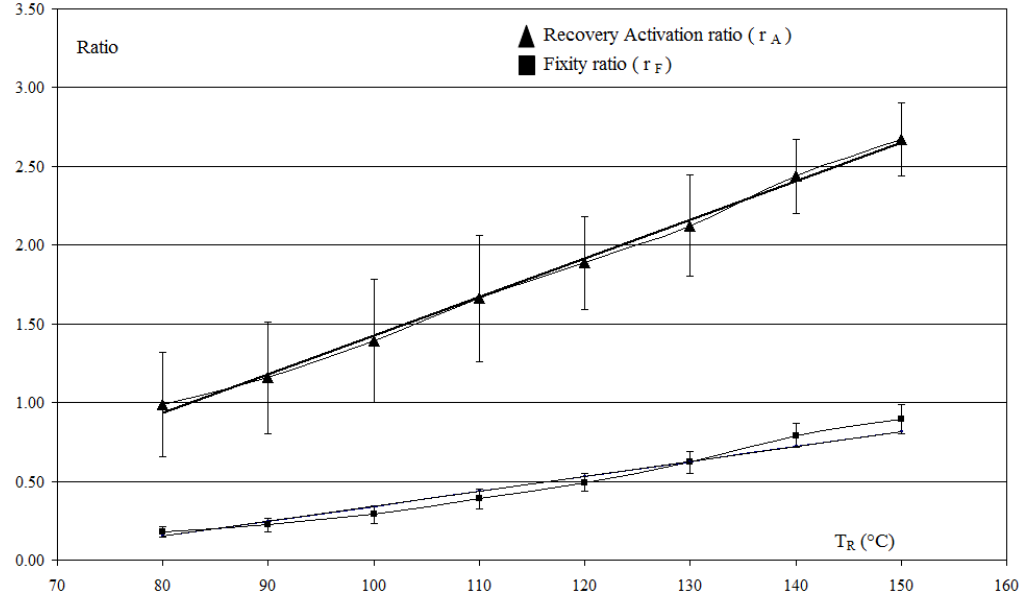
Figure 6. Multi-step unconstrained recovery activation ratio r for each T i and linear interpolation. R